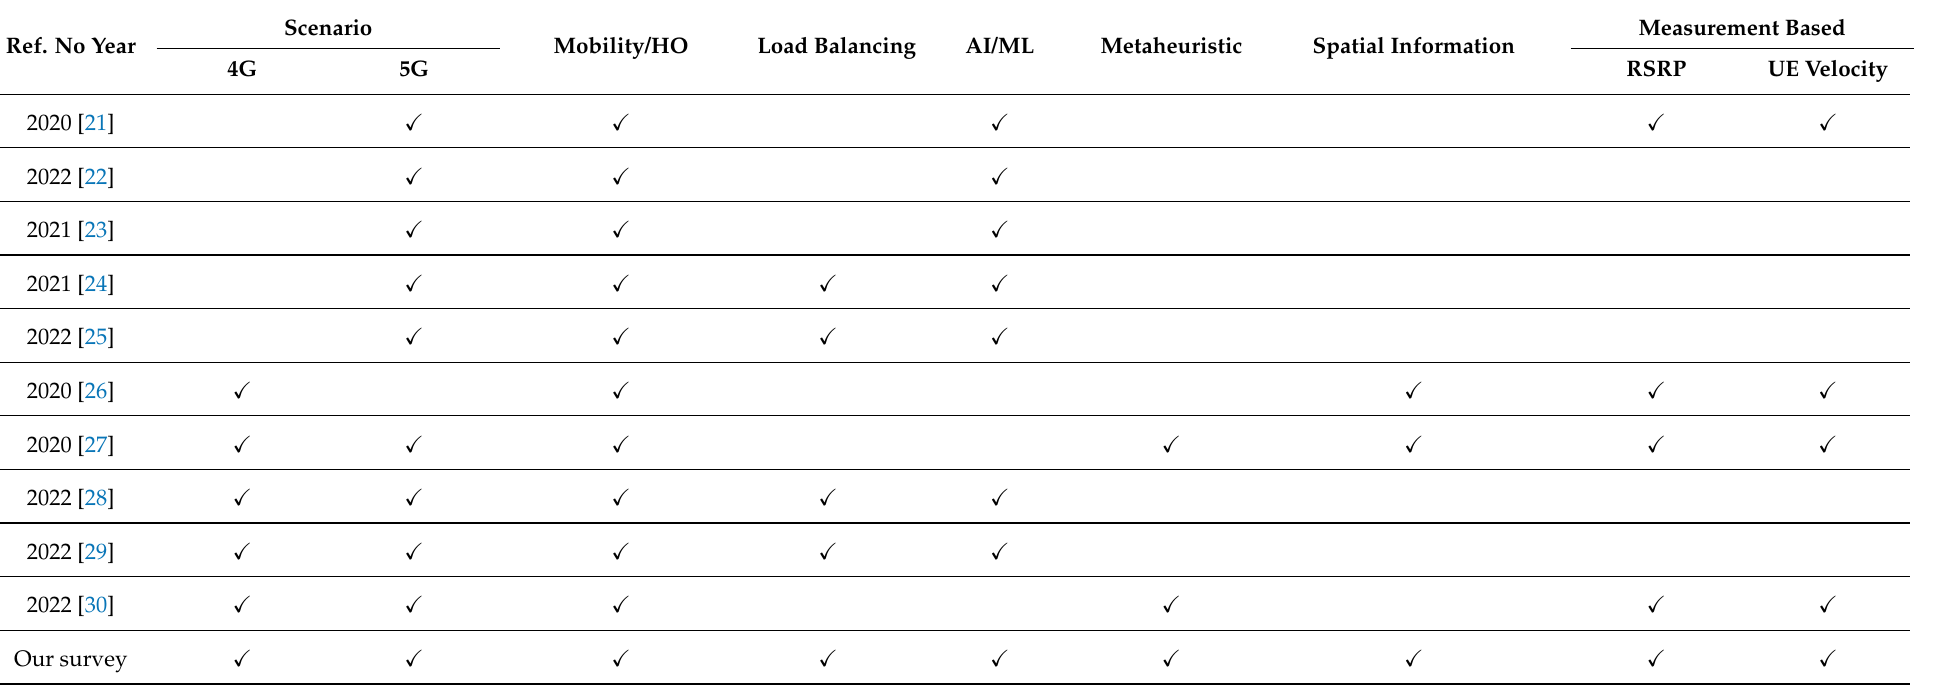
Table 1. Summary of Related